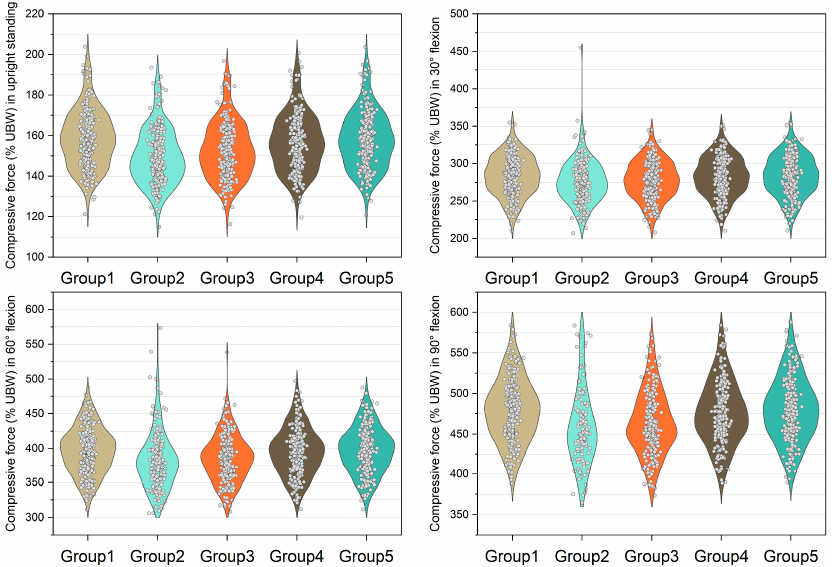
Figure 3. Normalized compressive force expressed by % upper body weight (%UBW) on the L5/S1 level. The grey circle denotes the value computed by each sample in each group.